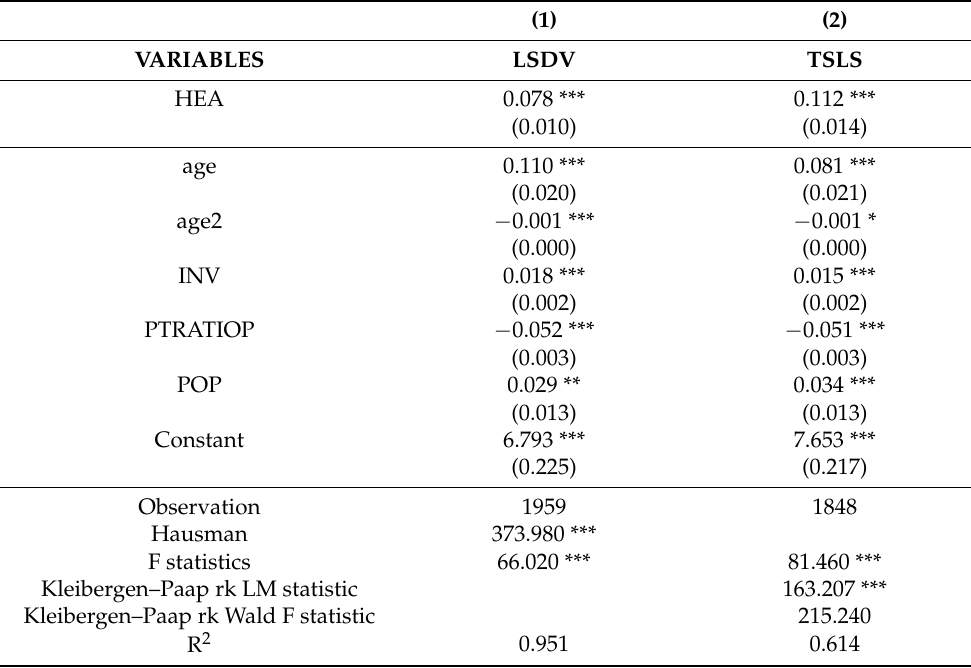
Table 5. Robustness test: Old-age dependency